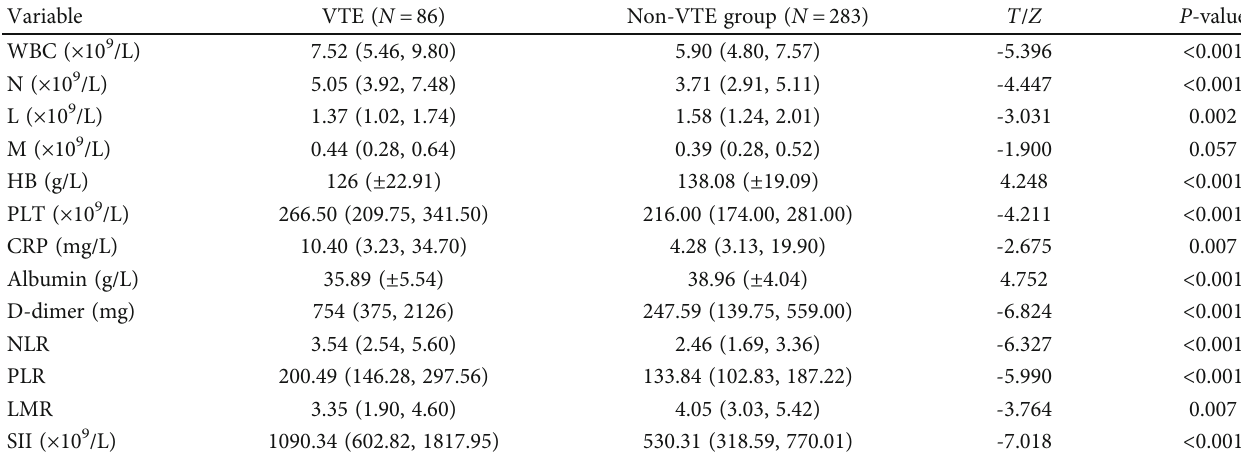
Table 2: Comparison of laboratory results between VTE groups and non-VTE groups.